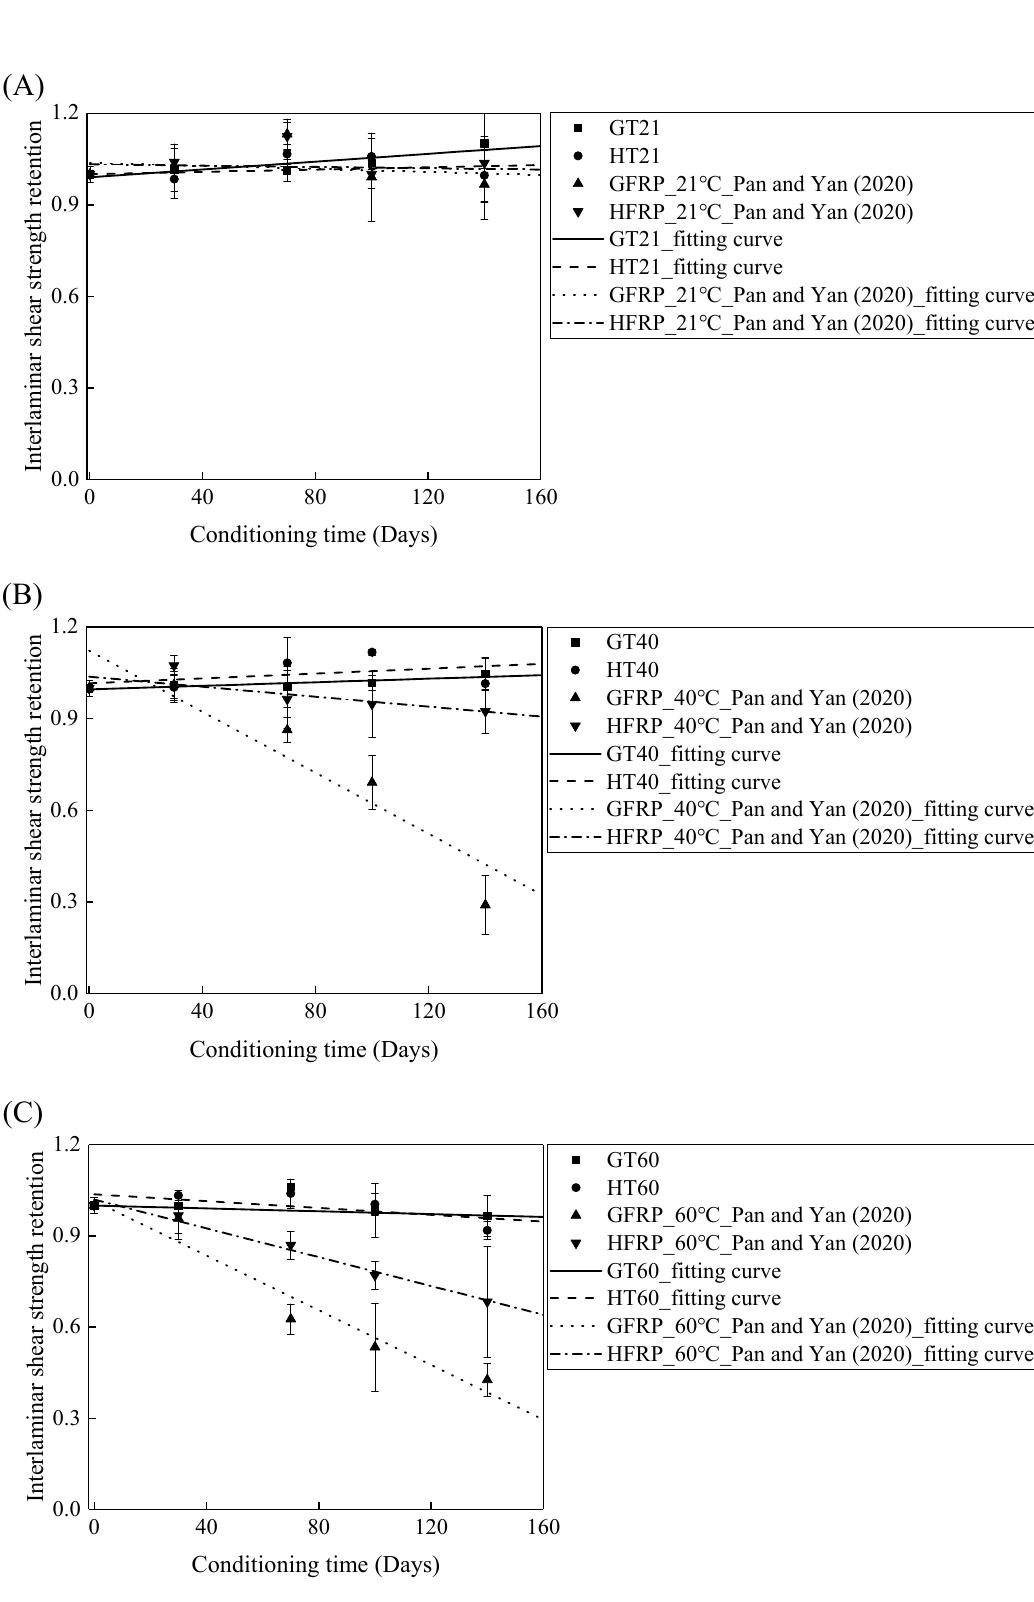
Figure 11. The comparison of the effects of the water and alkaline solution on the interlaminar shear strength of the FRP bars at a temperature of: ( A ) 21 °C, ( B ) 40 °C, and ( C ) 60 °C.